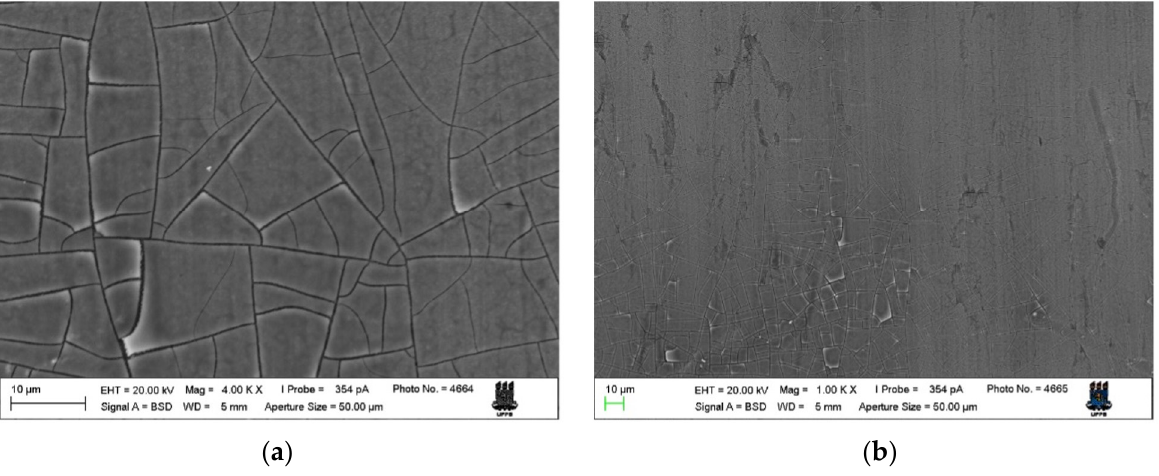
Figure 10. Scanning electron microscopy for samples with AT (acid treatment) and 1 min deposition time. Magnifications: ( a ) 4000×; ( b ) 1000×. Surface morphology analysis by SEM for samples that have been electropolished (EP) is illustrated in Figure 11.